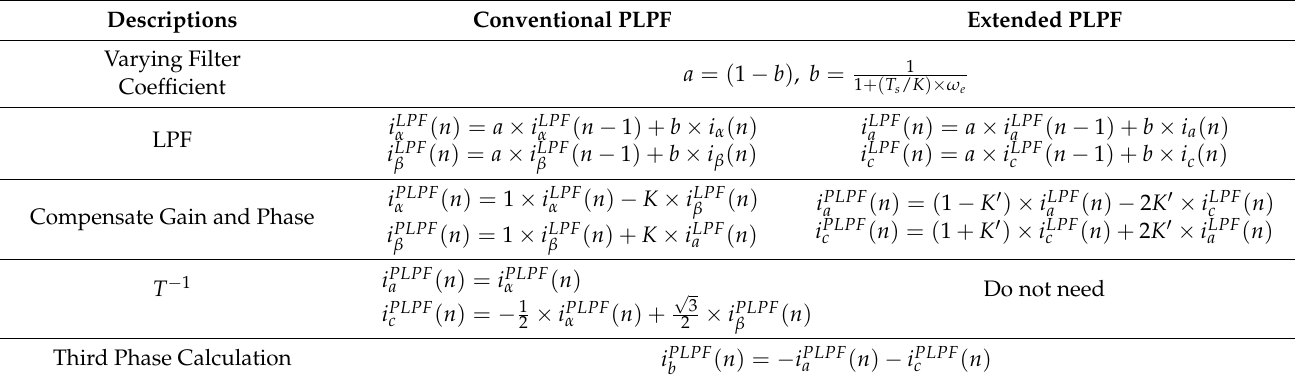
Table 1. Comparison between the conventional PLPF and Extended